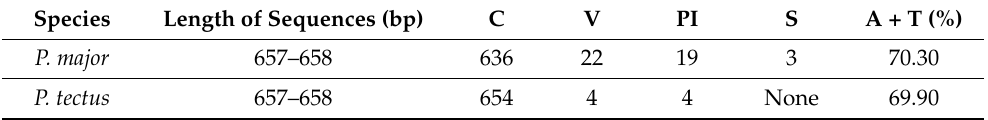
Table 2. Variation analysis of COI gene sequences of P. major and P. tectus . Species Length of Sequences (bp) C V PI S